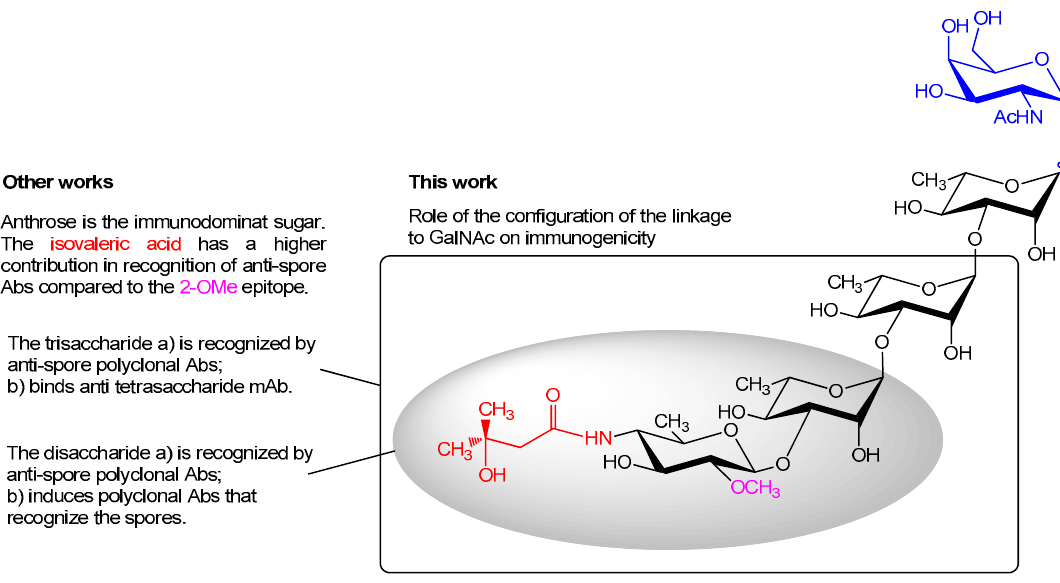
Figure 1. Chemical structure of the glycan decorating the exosporium BclA protein of B. anthracis and summary of the features contributing to the immunological properties of the tetrasaccharide portion. The square region denotes the trisaccharide portion of the glycan, while the grey oval area denotes the upstream disaccharide.